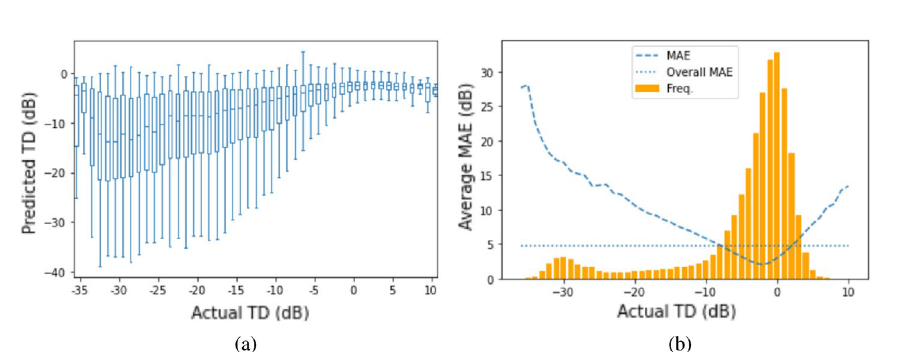
Figure 3. Analyses of the results obtained by RetiNerveNet (best viewed in color): ( a ) The plot of the actual versus estimated SAP TD values shows that RetiNerveNet is prone to respectively underestimating and overestimating the highly positive and highly negative TD values, with the performance being worst on the lower TD values. ( b ) RetiNerveNet is observed to be most accurate for the most frequent TD values. The error roughly in the range [− 8, 3] is observed to be lower than the overall average MAE (denoted by the horizontal dotted